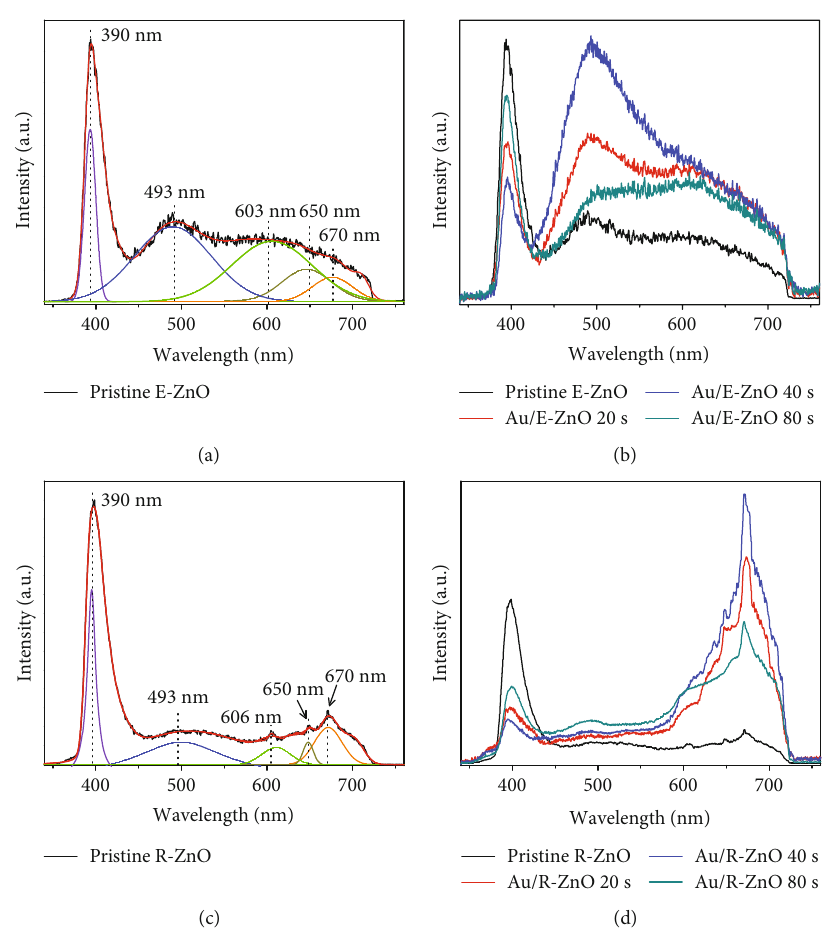
Figure 9: (a) – (d) Steady-state photoluminescence (PL) spectra of Au/ZnO Schottky heterojunction nanocomposites with di ff erent deposition times (0 s, 20 s, 40s, and 80s) excited by 266 nm,